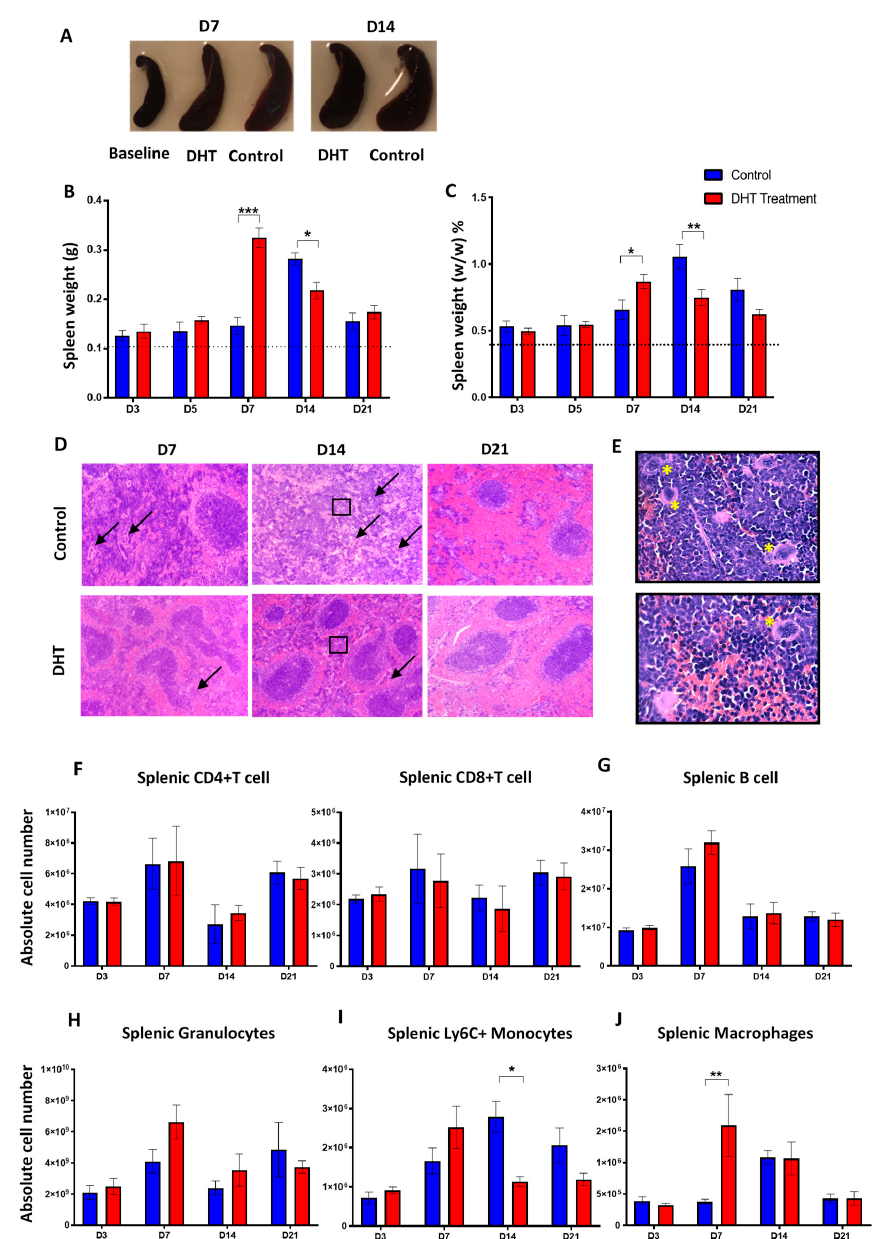
Figure 4. Spleen changes post major burn injury.( A ) Spleen enlargement in both groups post-major burn injury when compared to the baseline (non-injury) mice. ( B , C ) Spleen weight (g) and (%, w/w) increased significantly in control mice at day 14 while spleen weight (g and %) increase significantly in DHT-treated mice at day 7. ( D ) Representative H&E staining showing disorganised white pulp area with extensive infiltration of multi-nuclei cells (black arrow) in the red pulp area ( E ). ( F – H ) Flow cytometry to identify the numbers of splenic T cell (CD4+/CD8+, IAIE+, Lin+), B cell (IAIE-, Lin-) and granulocytes, which all peaked on day 7, followed by a reduction in both groups. ( I , J ) Flow cytometry to identify the numbers of splenic monocytes (Ly6C+, Lin-) and splenic macrophages (F4/80+, Lin-). Early increase of Ly6C+ monocytes, followed by a significant increase of macrophages on day 7 was observed in DHT treatment when compared to control. n = 6 per time point for control and DHT-treated mice. * p < 0.05, ** p < 0.01, *** p <